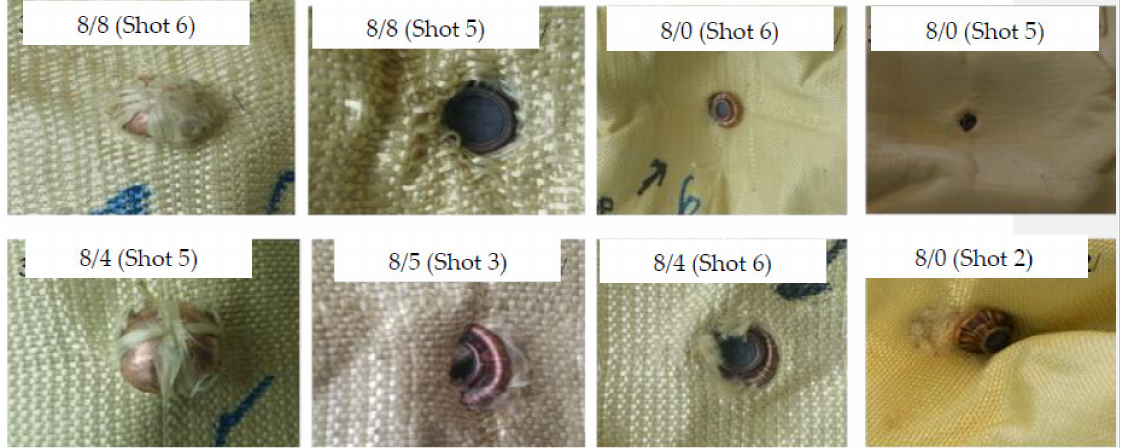
Figure 5. Some trapped projectiles inside the armour panel system.